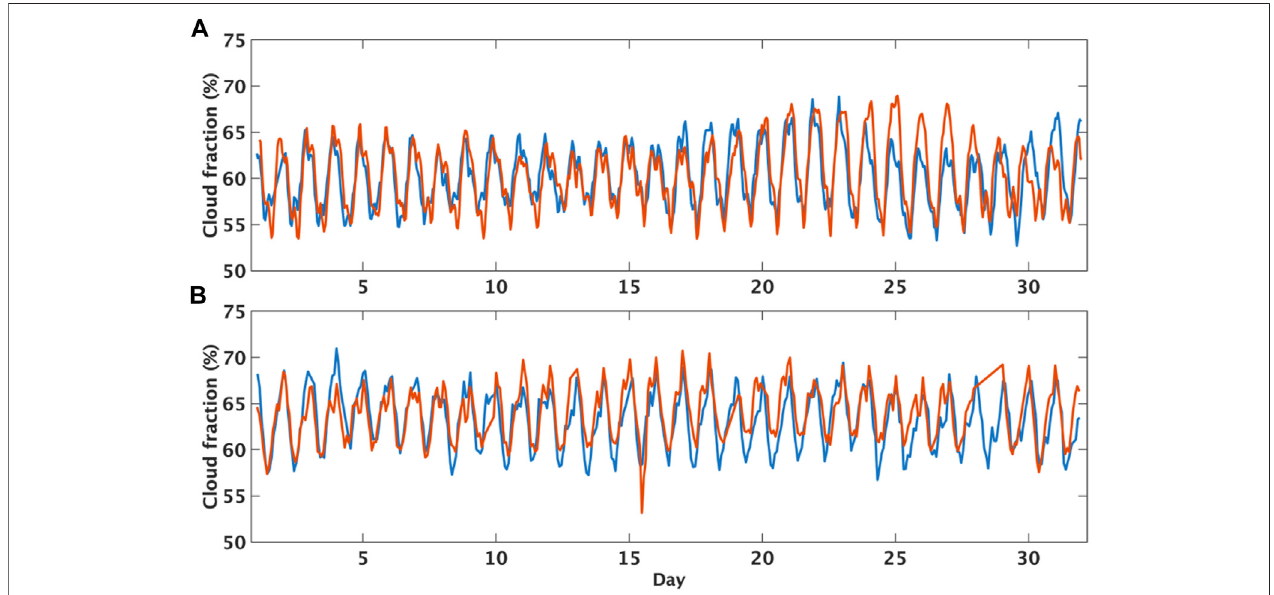
FIGURE6| ComparisonofglobaldaytimemeancloudfractionderivedfromEPICcompositebetween2017and2020for (A) Mayand (B) December.Bluelinesare for 2017 and red lines are for 2020.